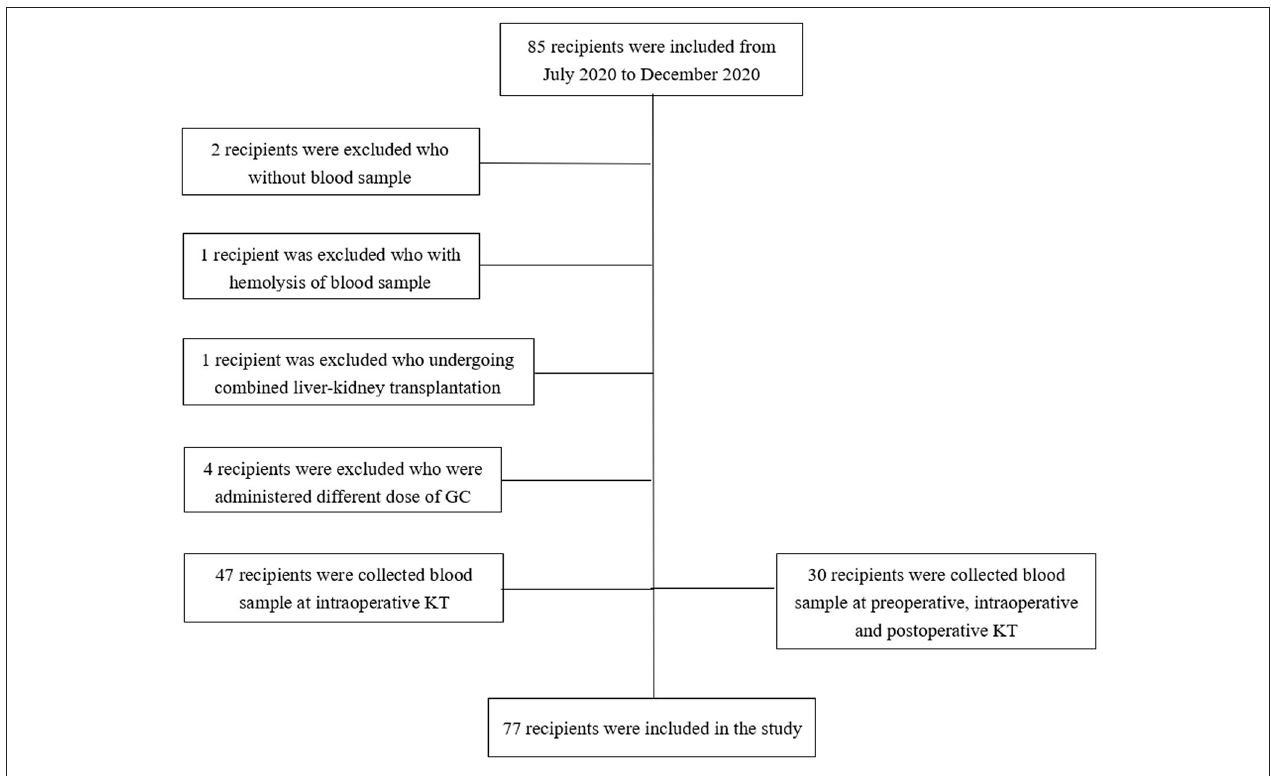
FIGURE 1 | Flow chart of kidney recipients enrolled in the